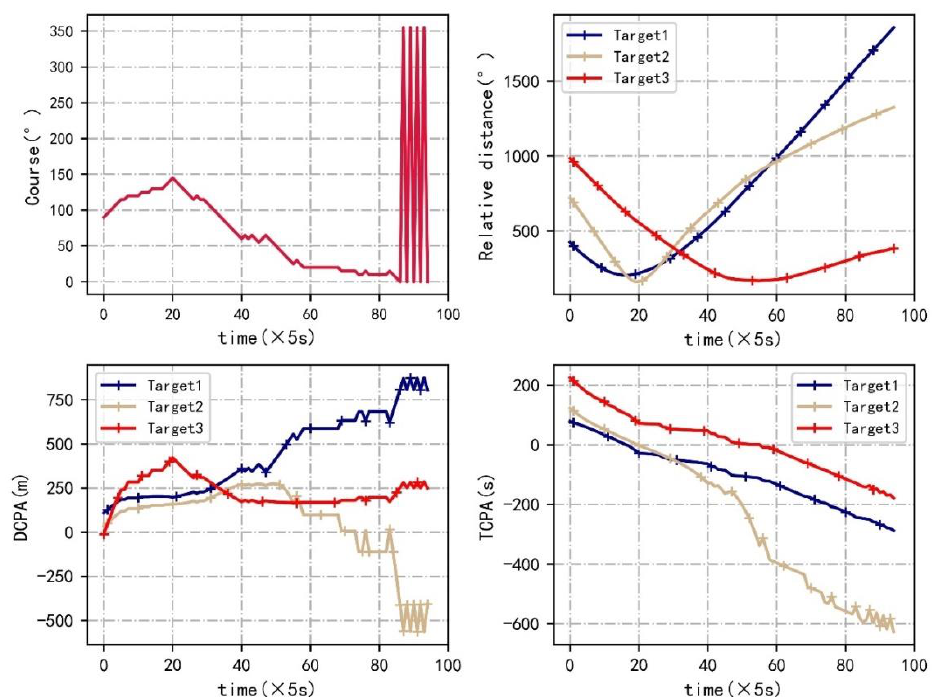
Figure 10. Course of ferry, relative distance, DCPA and TCPA when 𝑤 = 0.9.